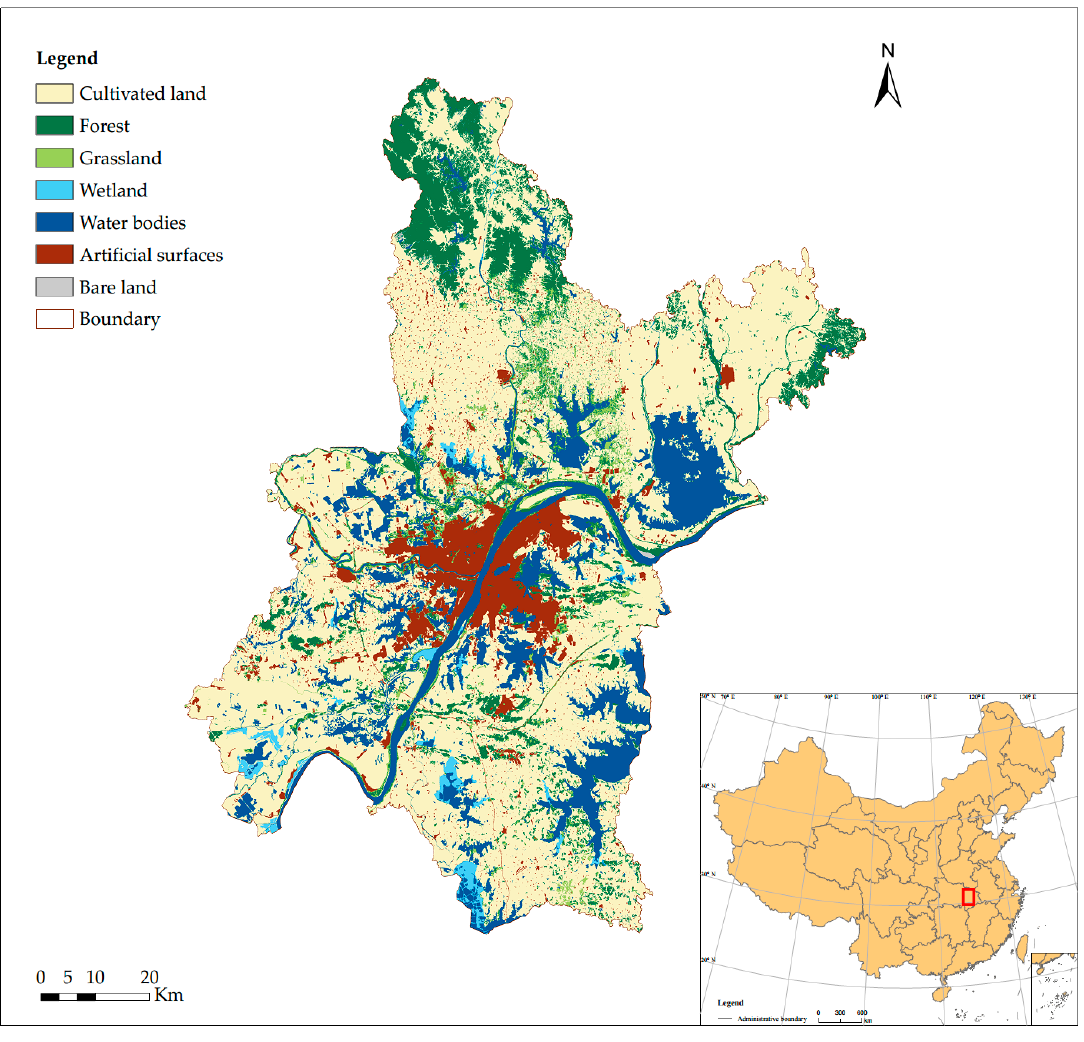
Figure 1. GlobeLand30 2010 land cover for Wuhan, China. Table 1. GlobeLand30 2010 land-cover